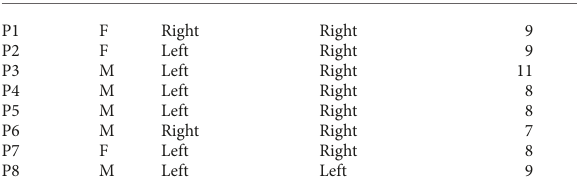
TABLE 1 Patient data.